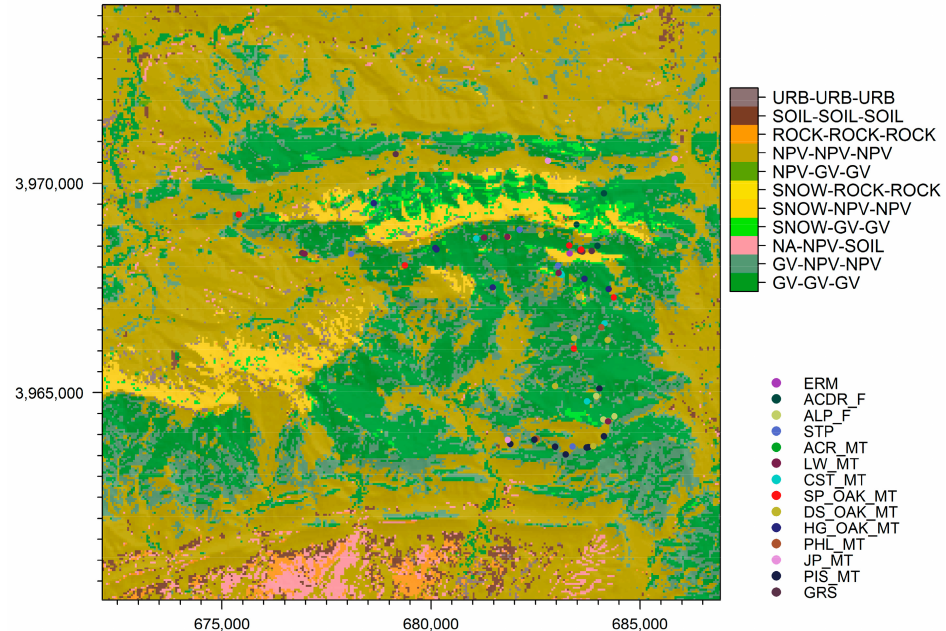
Figure 3. Land cover map of the Ouled Hann è che Mountains (coordinates are given in meters in the UTM31N projection system, DATUM